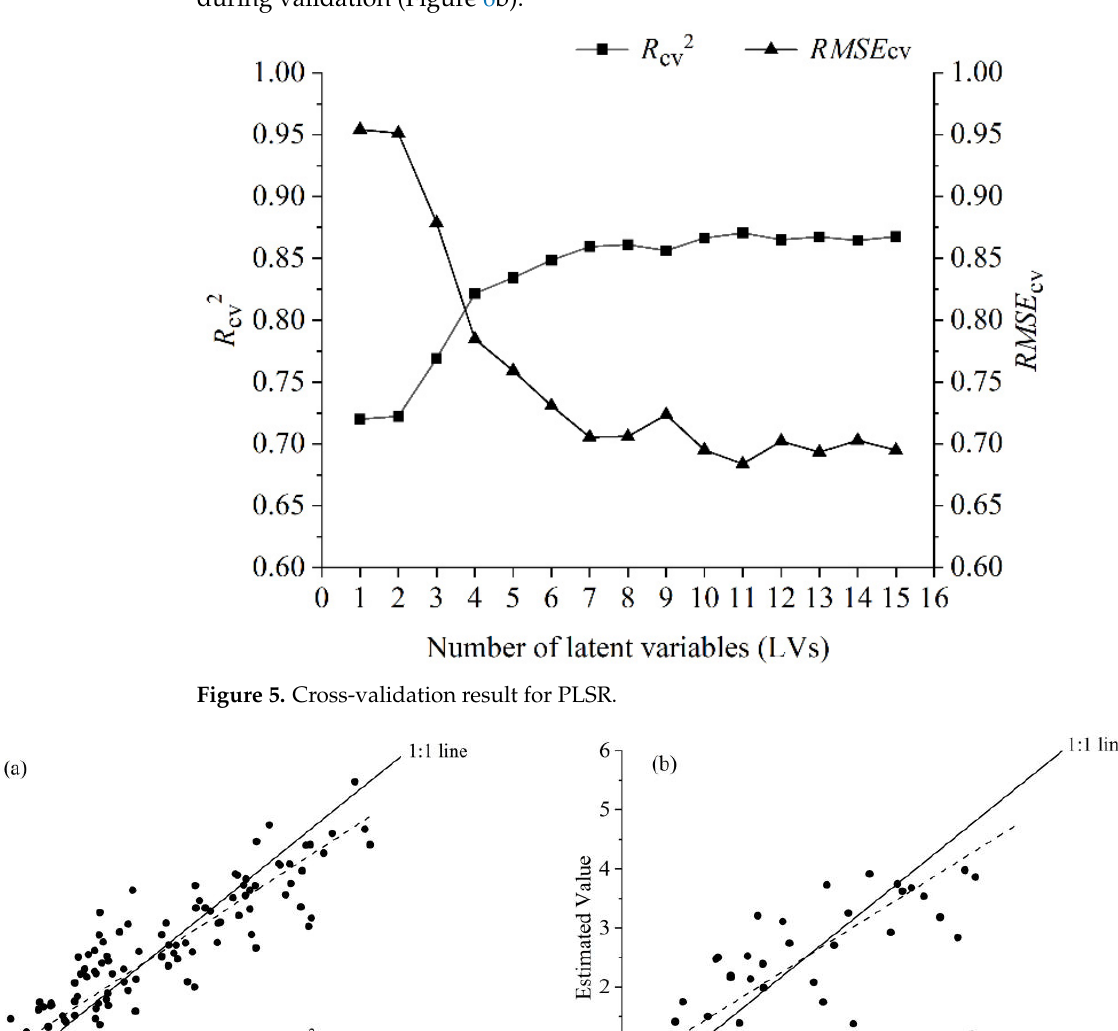
Figure 6. Results for the PLSR model. ( a ) Calibration; ( b ) Validation.